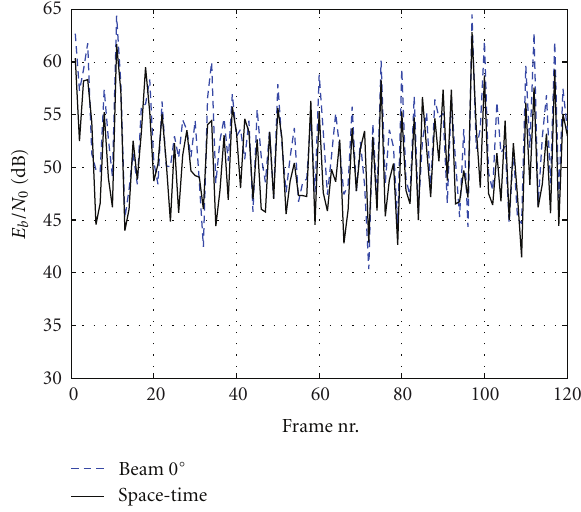
Figure 9: : E b /N 0 in non-line-of-sight conditions, with receiver diversity (MRC). NLoS transmissions performed at 20dB extra power compared to LoS